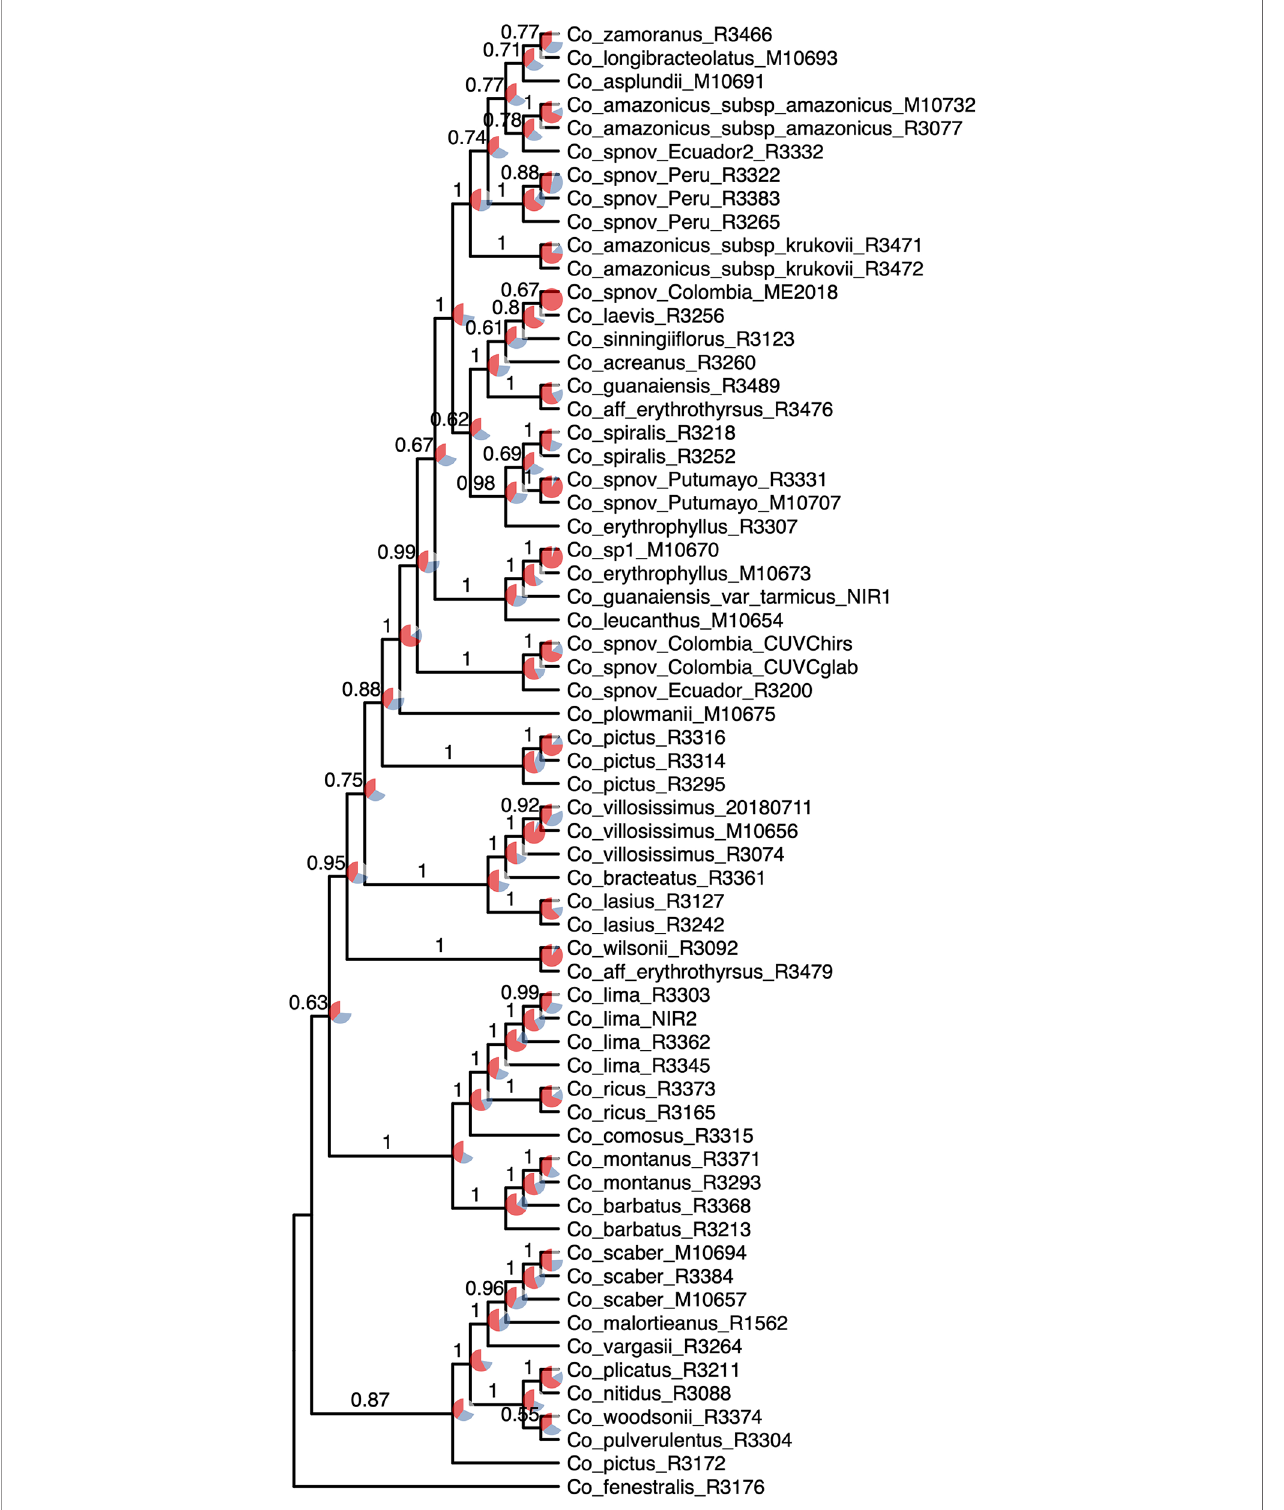
FIGURE 5 | Species tree reconstruction by ASTRAL with local posterior probabilities above the branches. Pie charts illustrate the quartet scores for each node for the 832 loci, with red representing the current topology, blue the second most favored topology, and white the remaining one. Equal branch lengths were used to allow the reader to distinguish support values; branch lengths are depicted in Figure 6